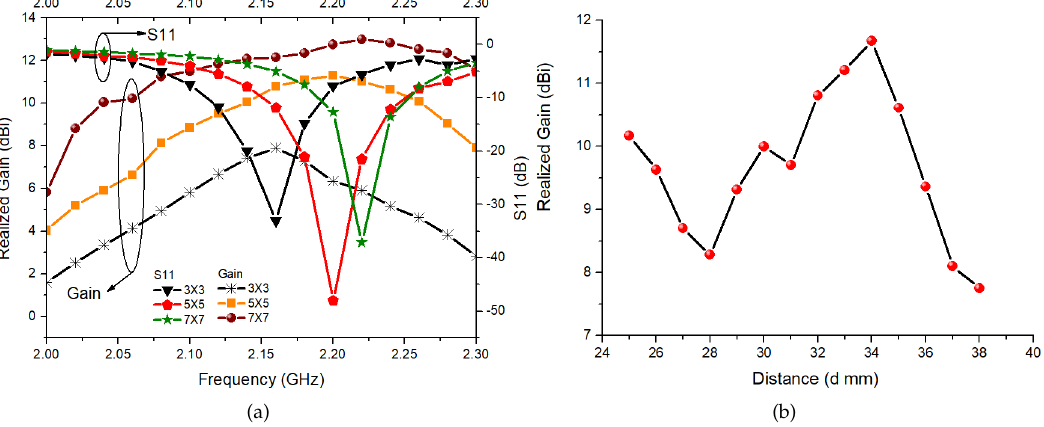
Figure 11. Optimization of the superstrate integrated design ( a ) Superstrate size versus gain and S11 ( b ) Superstrate height versus